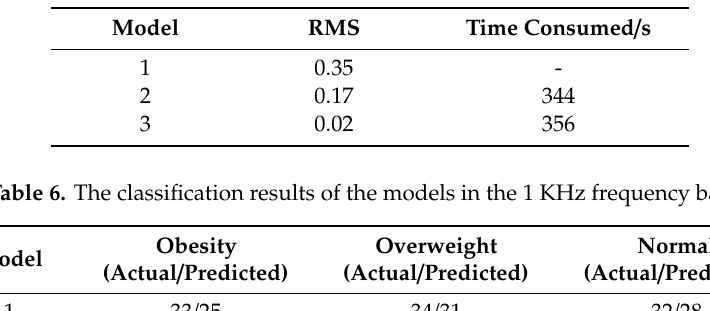
Table 5. RMS prediction errors of the three models in the 250 KHz frequency band.